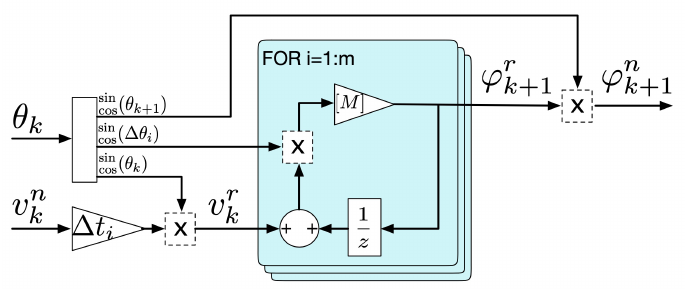
Figure 8. Discrete time model with fast rotation implementation: